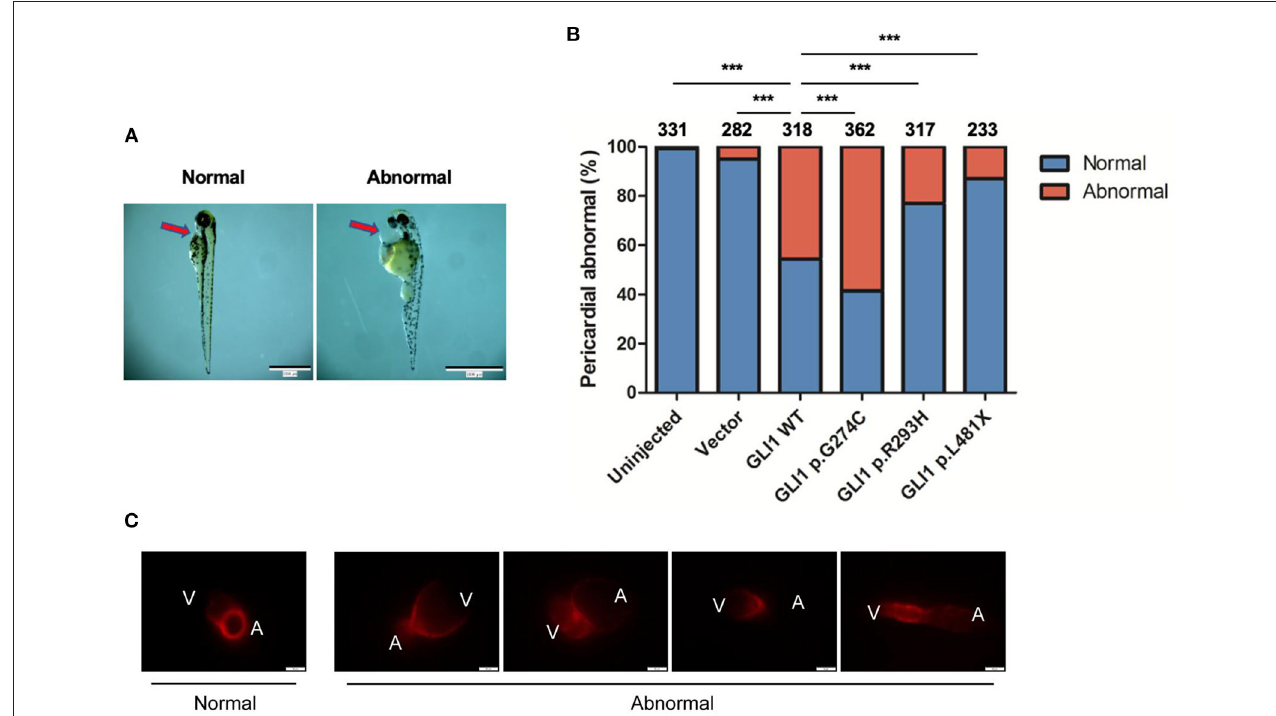
FIGURE 5 | Effect of overexpressed human GLI1 wild-type or mutant on zebrafish heart development. Empty vector or GLI1 wild-type/mutant expression construct were injected into 1-2 cell stage fertilized zebrafish embryos, and the teratogenic effect in zebrafish cardiogenesis was calculated 72h post injection. (A) Red arrows indicate the pericardial cavity of zebrafish embryos. (B) The frequencies of pericardial abnormalities. (n ≥ 200, * P < 0.05, ** P < 0.01, *** P < 0.001, compared with wild-type group). (C) Phenotype of Cmlc2-mCherry zebrafish after overexpressing wild-type human GLI1. GLI1 wild-type expression construct were injected into 1-2 cell stage fertilized Cmlc2-mCherry zebrafish embryos. Images were captured with Olmpus IX83 72 hours post injection. V, ventricle; A,